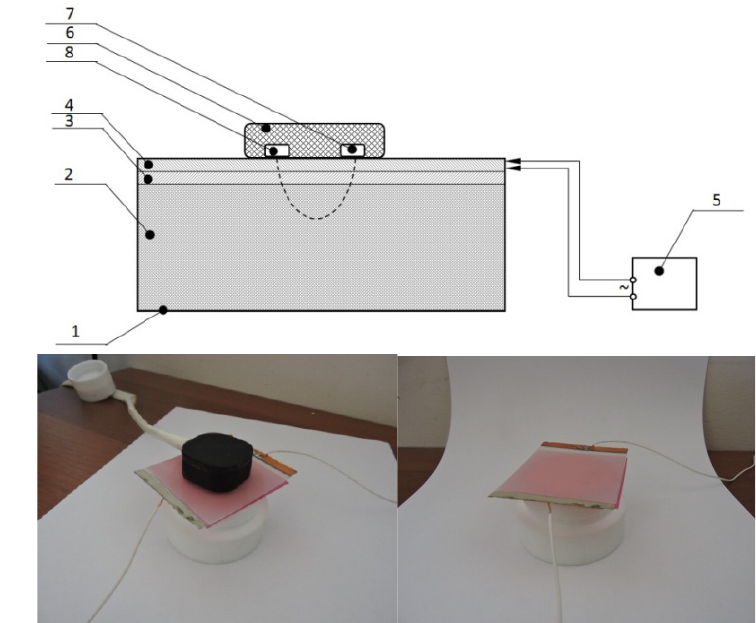
Table 3. Optical properties of the fluoroplastic F-4 measure base.